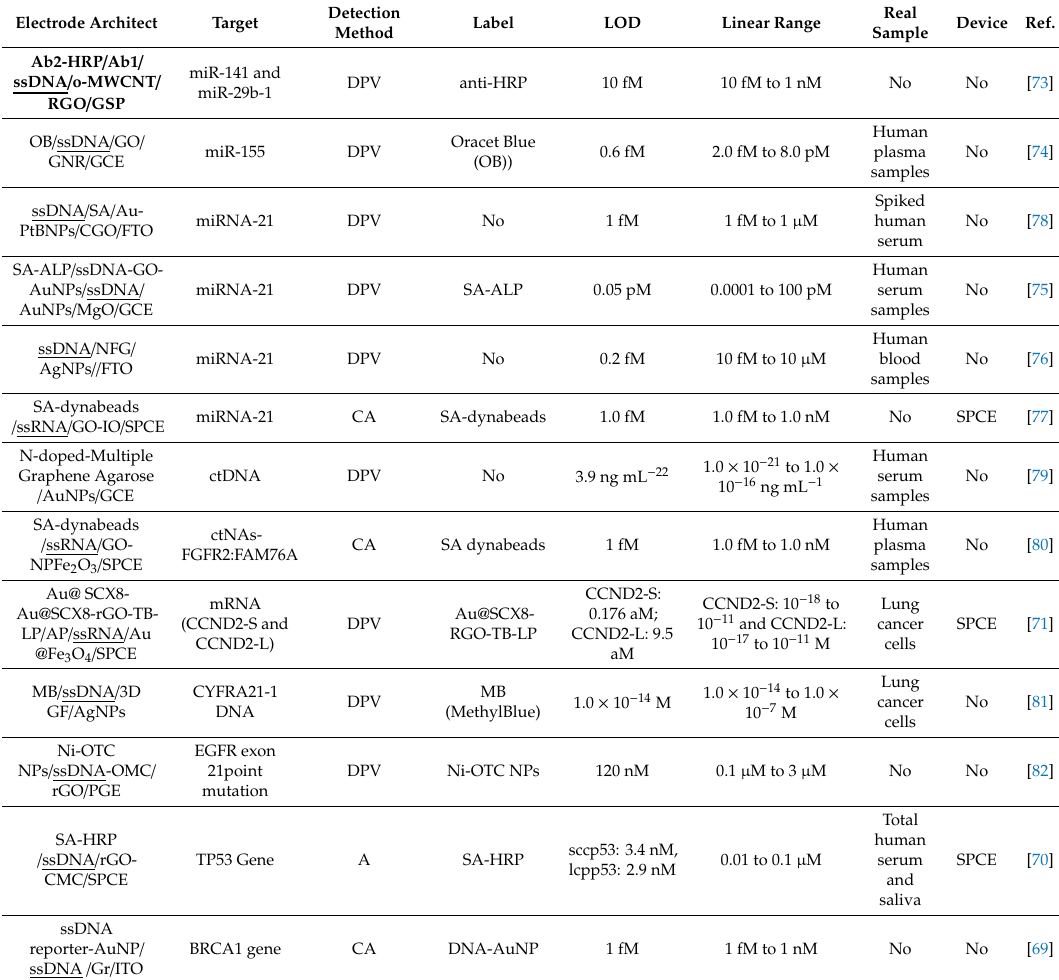
Table 1. Graphene-based electrochemical genosensors for nucleic acid detection. The underlined terms are the